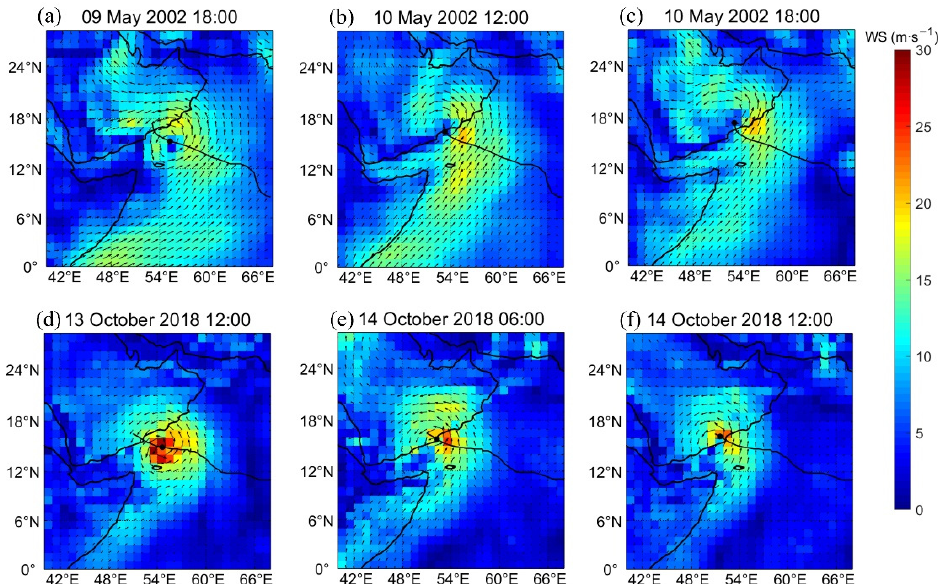
Figure 4. Wind speed (m/s) distribution of ARB 01 on ( a ) 9 May 2002 18:00, ( b ) 10 May 2002 12:00, and ( c ) 10 May 2002 18:00, and Luban on ( d ) 13 October 2018 12:00, ( e ) 14 October 2018 06:00, and ( f ) 14 October 2018 12:00. Black dots indicate the TC center. Table 3. Average wind speed in a radius range of 400 km (400–1000 km) around the TC center. Average Wind Speed Tropical Cyclone Date and Time